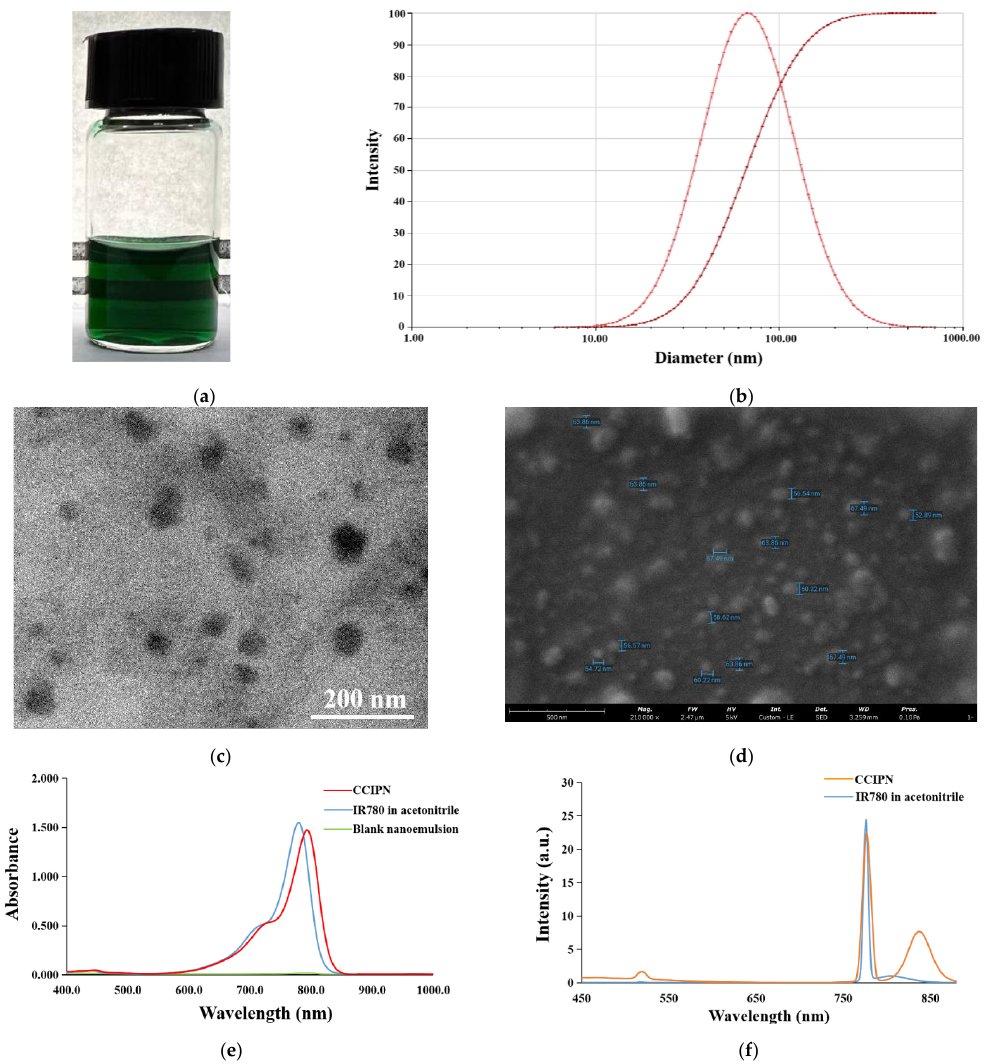
Figure 4. Physicochemical properties of CCIPN. ( a ) The appearance of CCIPN; ( b ) The droplet size distribution of CCIPN; ( c ) Transmission electron microscopy image of CCIPN. Water was used as the aqueous phase to avoid the influence of PBS on the photograph; ( d ) Scanning electron microscopy image of CCIPN. Water was used as the aqueous phase to avoid the influence of PBS on the photograph; ( e ) Absorption spectra of CCIPN, IR780 in acetonitrile, and blank nanoemulsion; ( f ) Fluorescence spectra of CCIPN and IR780 in